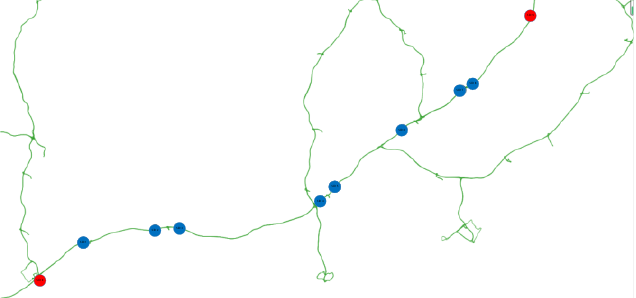
Figure 2. Topology diagram of an OD expressway route.